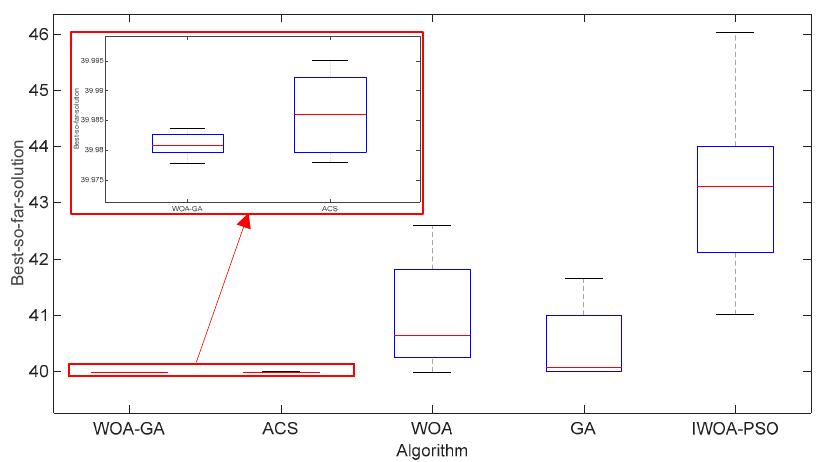
Figure 3. Best-so-far feasible solution from WOA-GA, WOA, GA, IWOA-PSO and ACS. The travelling time of the best solution from WOA-GA is 29.9930 s, where T 1 = 0.0030 s, T 2 = 10.8240 s, T 3 = 8.9690 s, T 4 = 10.1850 s and T 5 = 0.0120 s. Figures 4–7 illustrate the trajectory curves of the industrial robot and their derivatives, including jerk, acceleration and velocity. As shown in Figure 7, the jerk curves of all joints were continuous, which resulted in the smoothness of the optimized trajectories. Furthermore, the values of jerk, acceleration and velocity were zero at the start and end movement. The motion curves were all bound under the kinematic constraints all the time. Therefore, the proposed method is an effective time-jerk optimal trajectory planning tool for industrial robots.